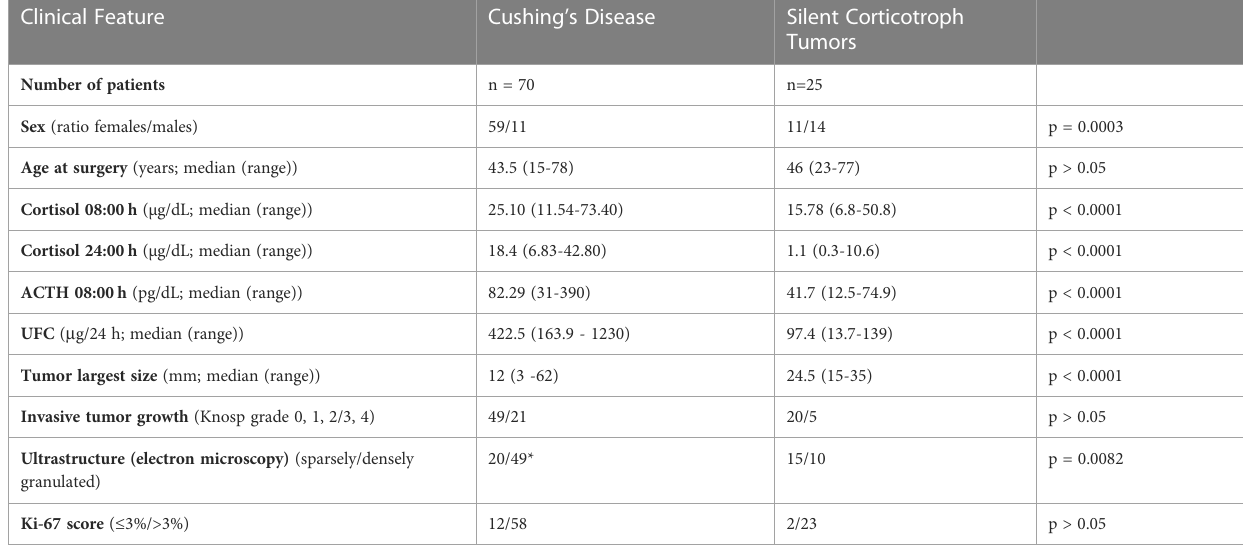
TABLE 1 Summary of clinical features of patients with Cushing ’ s disease and silent corticotroph tumors. Clinical